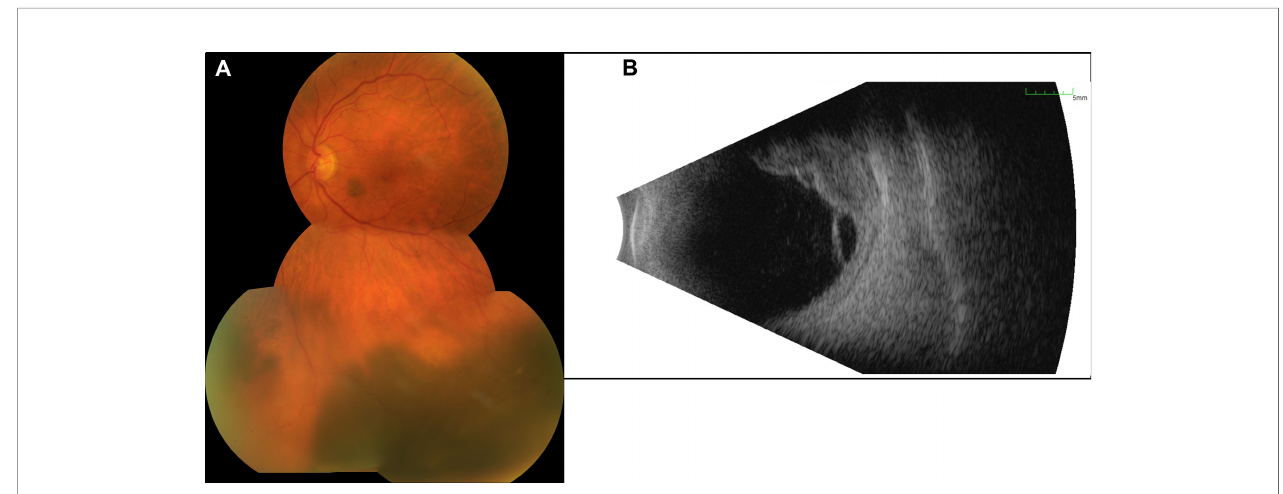
FIGURE 1 | Presentation of the initial tumor. (A) The image of the posterior pole illustrates a melanotic tumor with subretinal fl uid. (B) The B-scan ultrasound reveals a multilobulated tumor with a size of 13.6 × 10.8 mm and a thickness of 6.0 mm and with surrounding subretinal fl